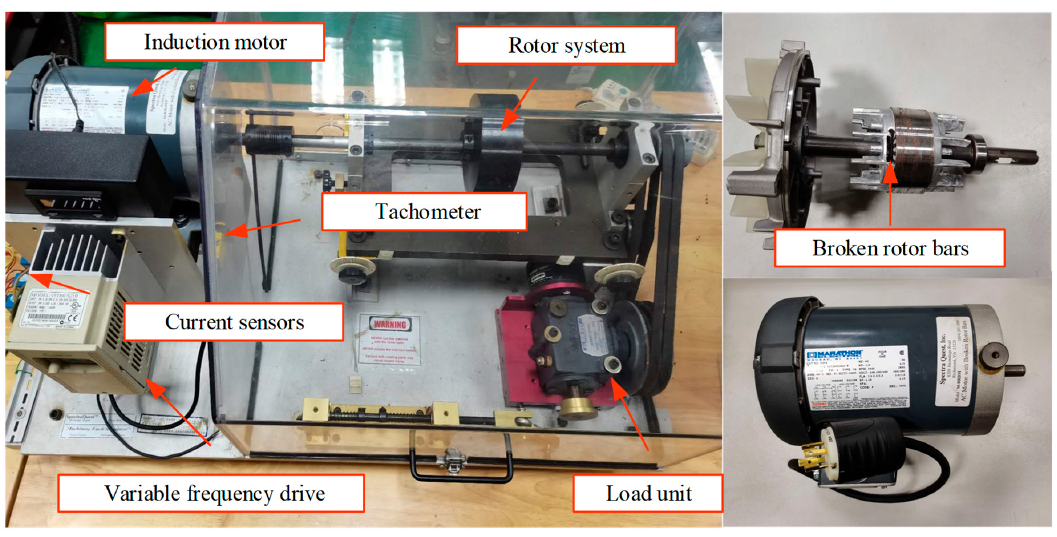
Table 1. The detailed parameters of the Induction Motor (IM). Parameters Value Number of poles